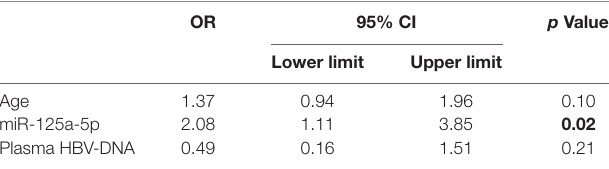
TaBle 3 | Multiple logistic regression analysis for independent predictors of staging > 5.